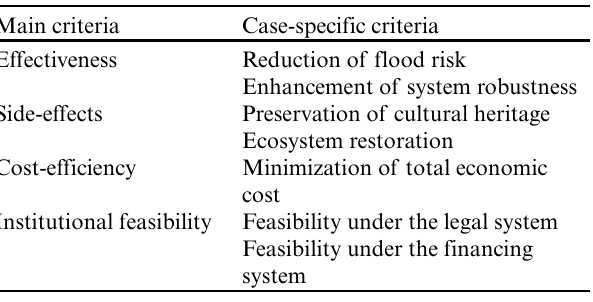
Table 1 . VGS analytical